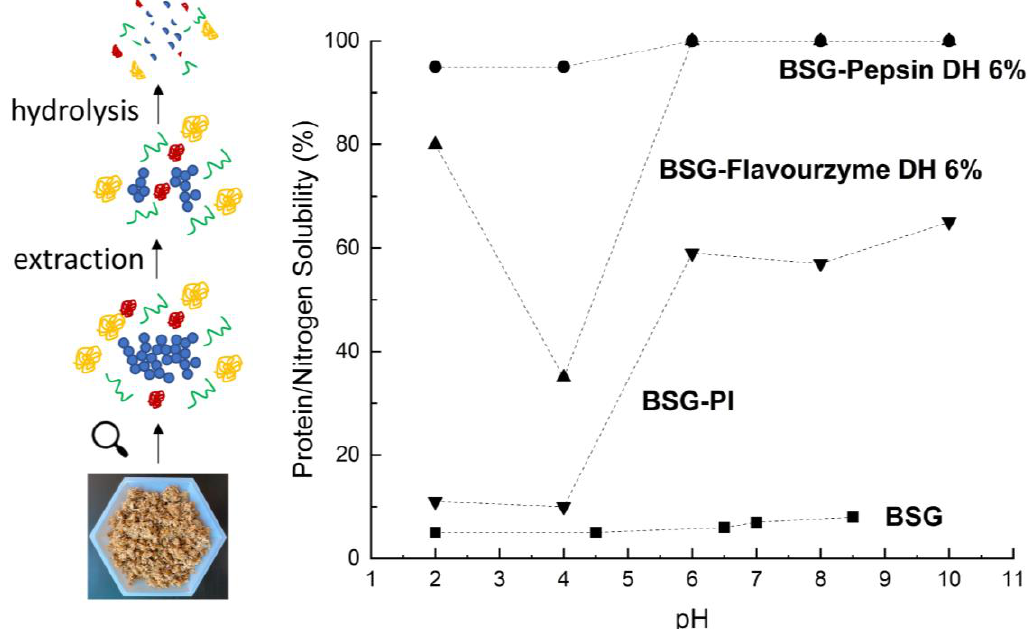
Figure 2. Proteins found in brewer’s spent grain have low solubility, but protein extraction and en- zymatic hydrolysis considerably enhance protein solubility over a broad pH range. Data approxi- mated from Conolly et al. [37], Bi et al. [80], and Marcus and Fox